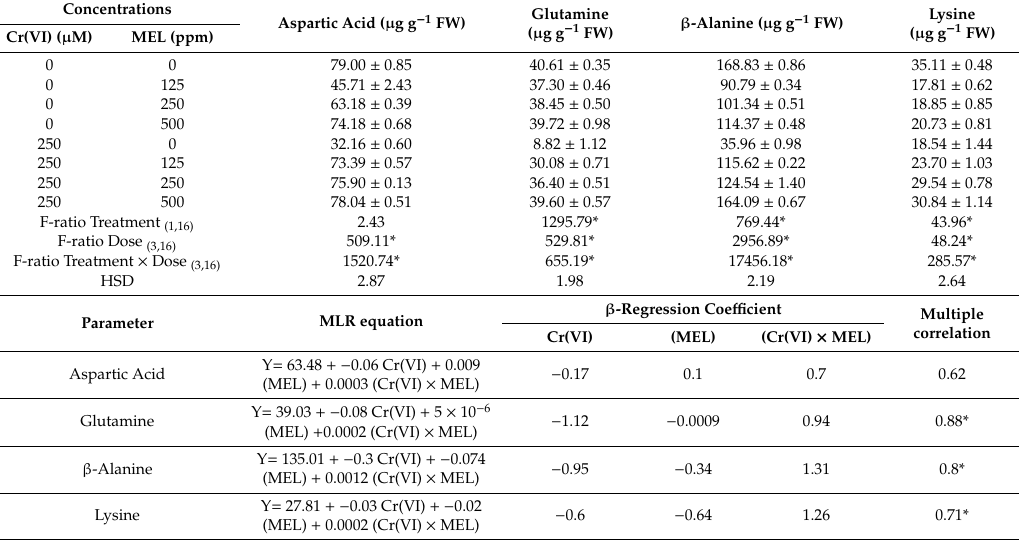
Table 8. Effect of Cr(VI), different concentrations of methanol extract of Rhododendron arboreum leaves (MEL), and their combinations on aspartic acid, glutamine, β -alanine, and lysine contents in 7-day-old Vigna radiata seedlings. The values are the means of three replicates ± SD. (standard deviation). Tukeys test performed and significance checked at * p ≤ 0.05. The F ratio is the term in which ANOVA is represented; Cr(VI) = Dose, MEL treatments = Treatment and combination of Cr(VI) and MEL = Dose ×